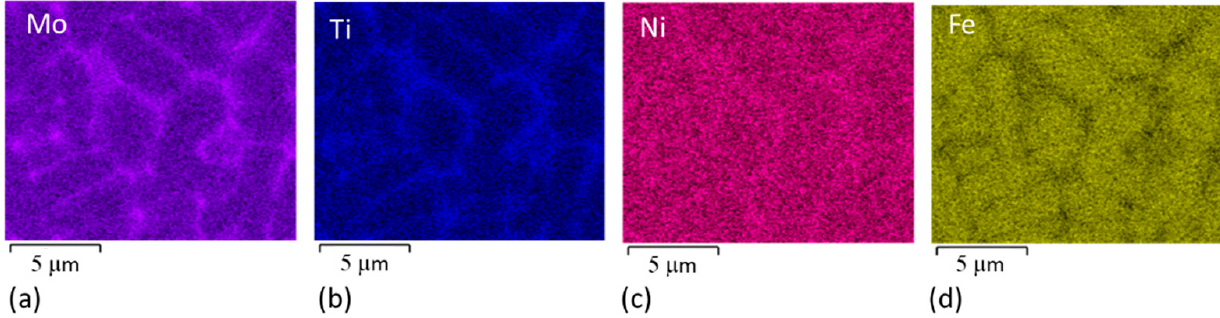
Figure 5. Energy ‐ dispersive X ‐ ray spectroscopy (EDS) analysis on a metallographic section through the powder with distinct segregation of ( a ) Mo, ( b ) Ti, ( c ) slight segregation of Ni and ( d ) lack of Fe along cell boundaries.